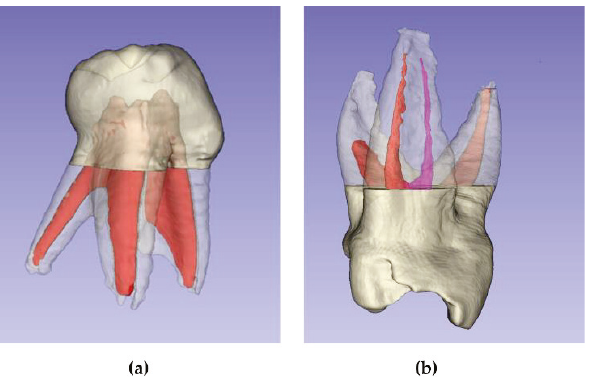
Figure 10. Anatomical peculiarities: ( a ) Mandibular 1st molar with supernumerary root; ( b ) Collateral canal in mesial root.